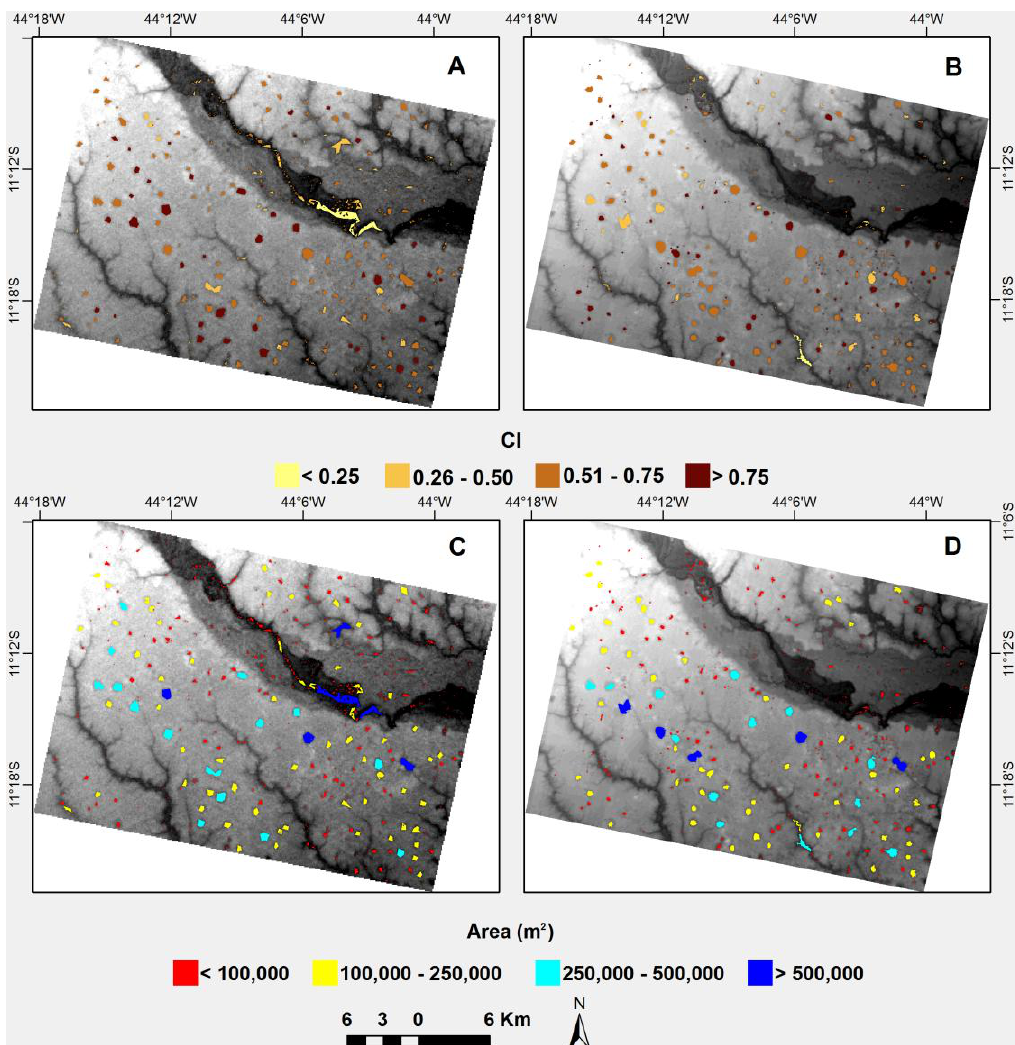
Figure 9. Spatial distribution of dolines considering the following attributes: area from ( A ) SRTM-DEM and ( B ) ALOS/PRISM-DEM, and circularity indexes from ( C ) SRTM-DEM and ( D )